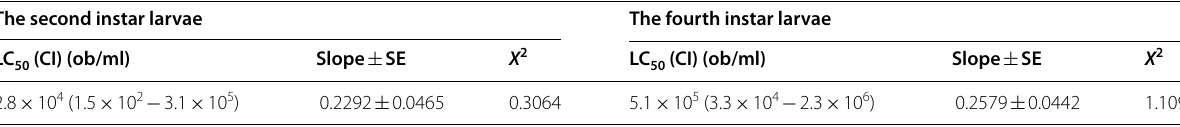
Table 1 Median lethal concentration (LC ) of SpliNPV-WY virus infection against second and fourth larvae instar of Spodoptera 50 littoralis after 10 days SpliNPV-WY viral infection